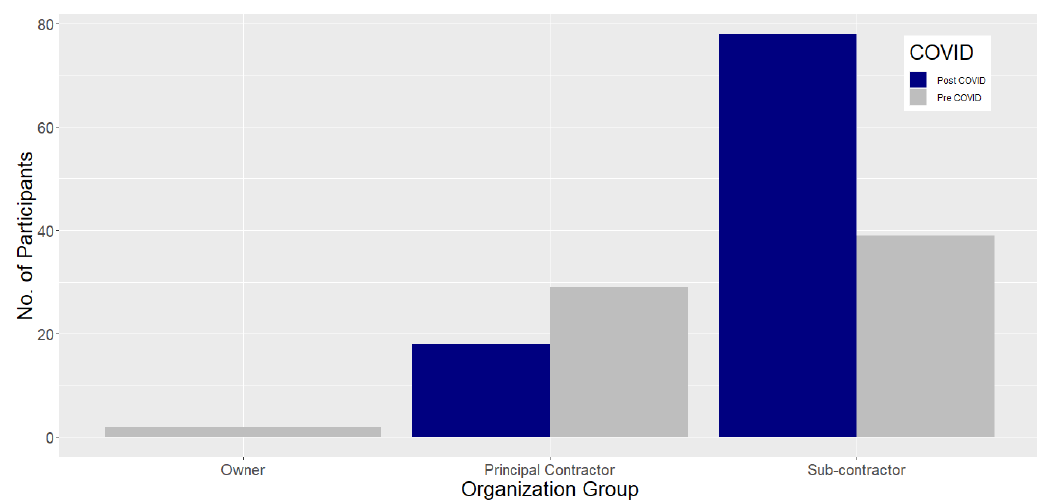
Figure 2. Participating